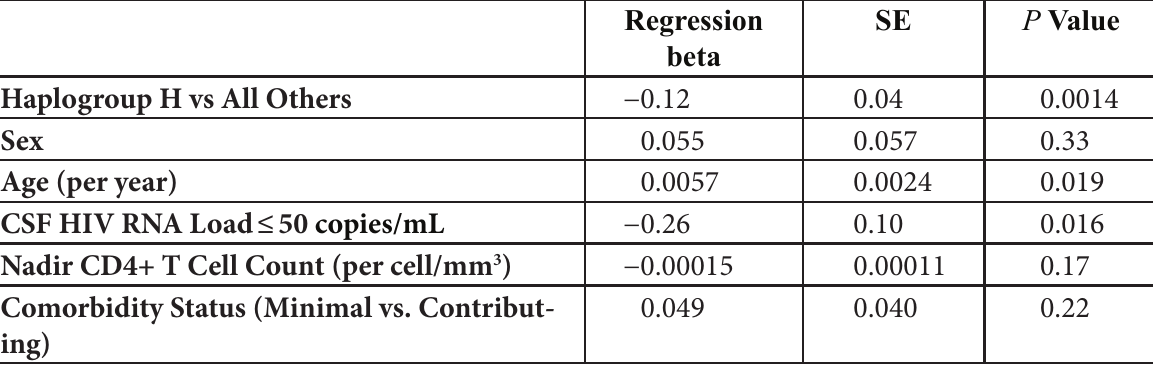
Table 2. Multivariate linear regression results for log CSF TNF-α with mitochondrial haplogroup H for participants with undetectable HIV RNA on ART (N = 89).